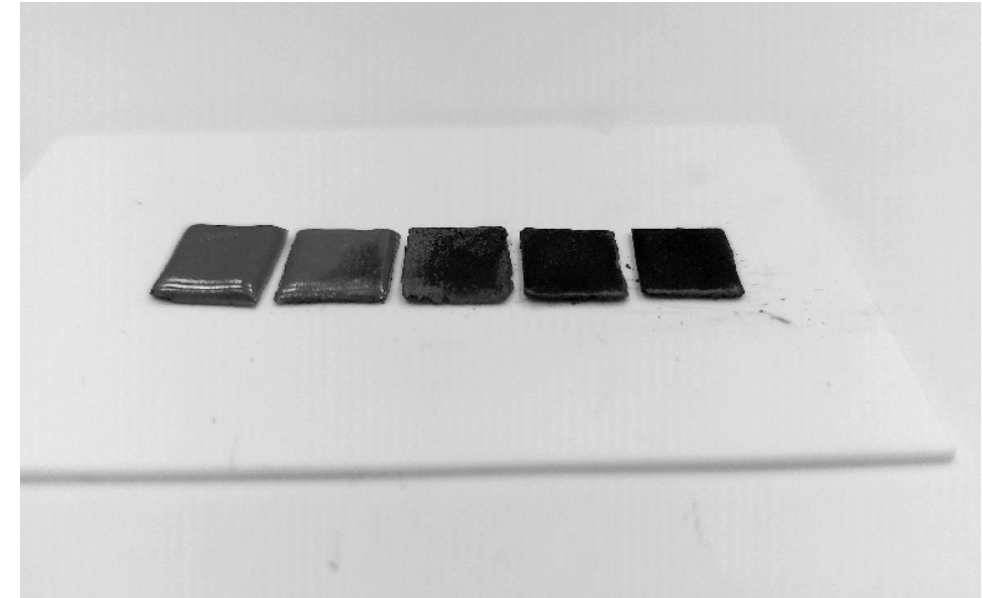
Figure 8. Photograph of NiO/YSZ anodes printed at different laser exposures before thermal sin- tering.